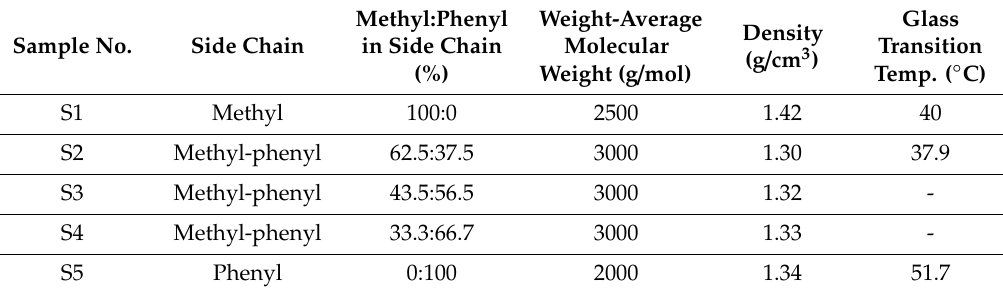
Table 1. Properties of the five silicone resins used in this study.